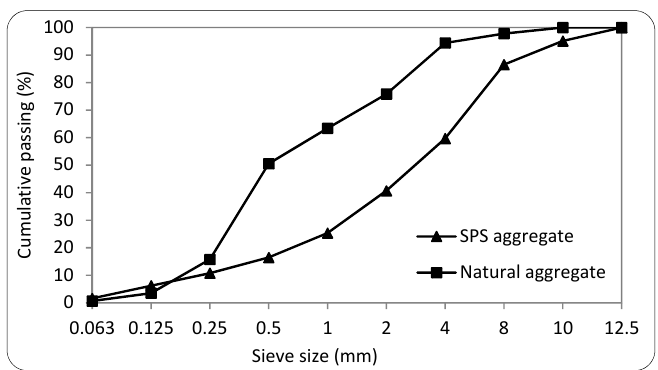
Figure 3. Novel SPS lightweight aggregate.